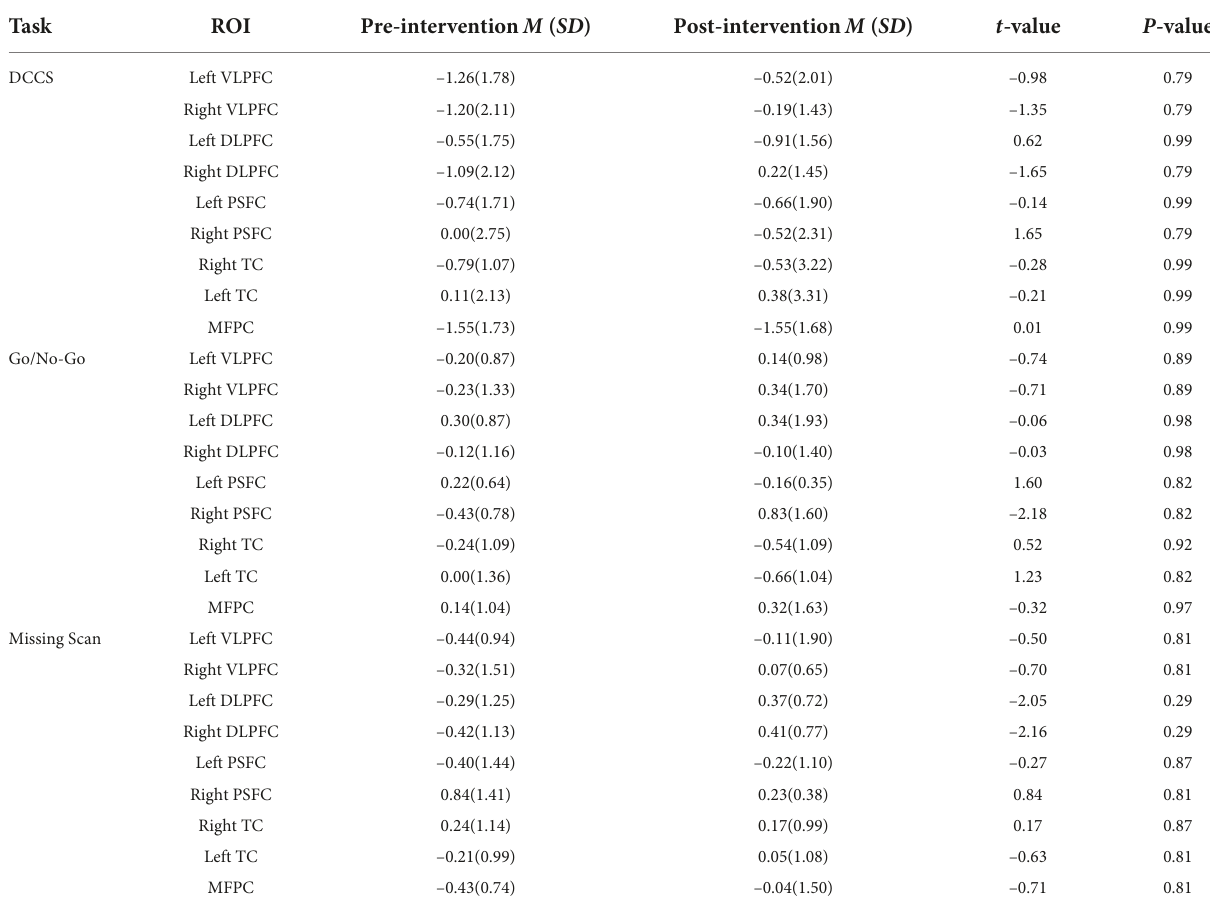
TABLE 4 Comparison of increases in HbO before and after the intervention for girls ( N =